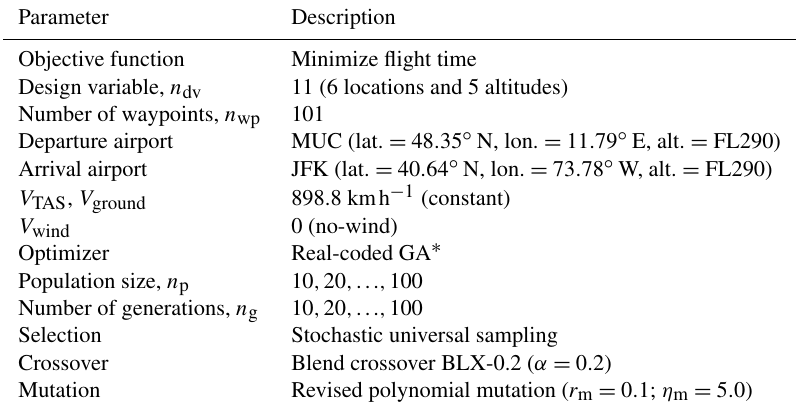
Table 5. Calculation conditions for the benchmark test on flight trajectory optimizations.